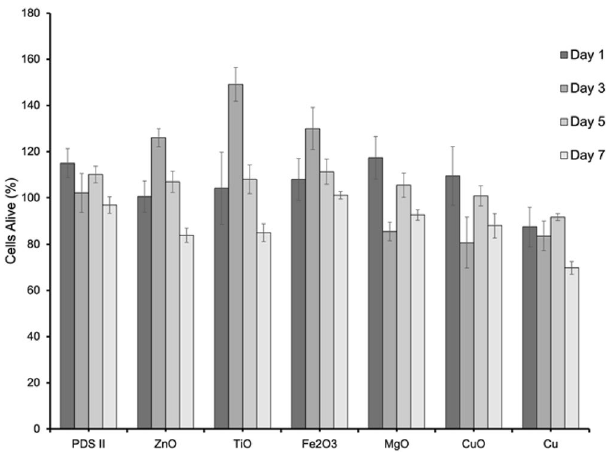
Figure 6. Mean percentage of live CHO cells under different metallic nanoparticle suture coating treatments (n = 12). Four timepoints were observed at 1, 3, 5 and 7 days after exposure to coated